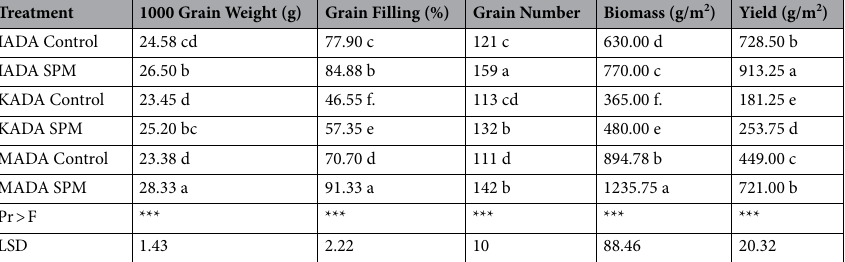
Table 9. Yield components of treatment combination. Means followed by the same letter in the same column are not significantly different at p ≤ 0.05 according to Fisher’s least significant difference (LSD). ***